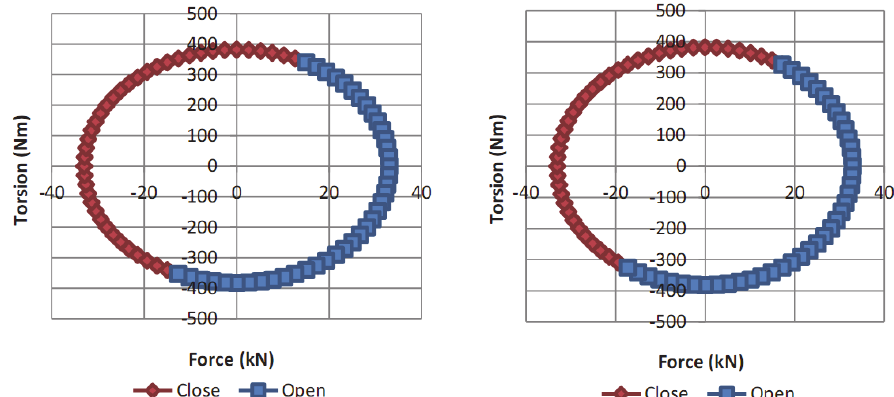
Figure 9: Force-Moment Diagram from the simulation (left) and from experiment (right) of R-031 (axial and torsional non- proportional mixed load), a=4